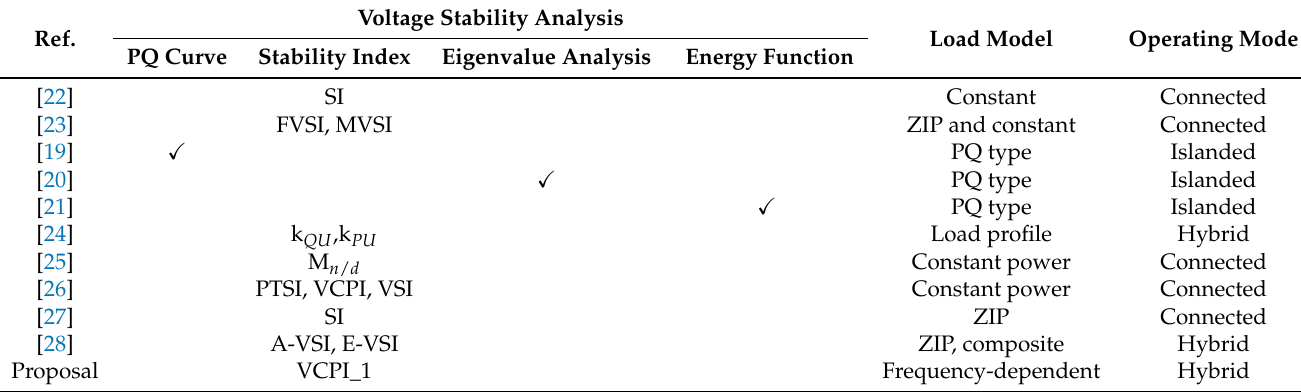
Table 1. Comparison of voltage stability analysis on ADN.